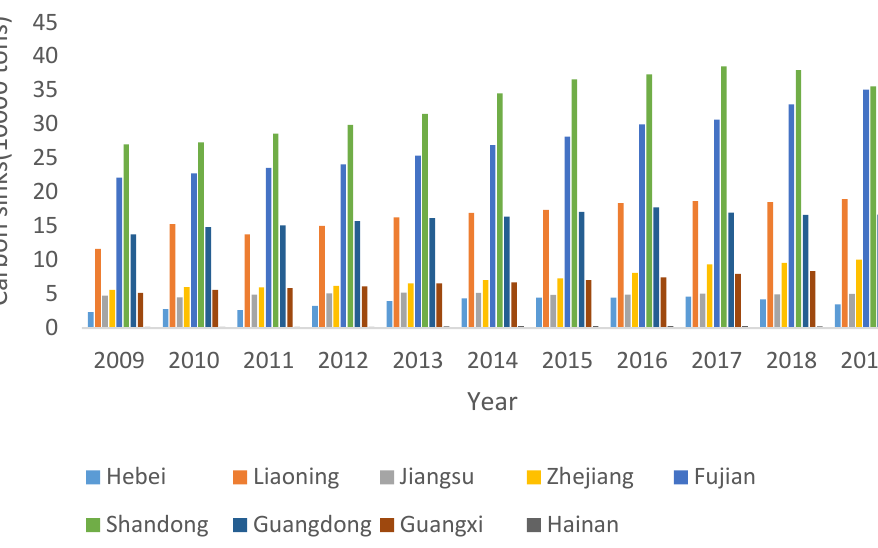
Figure 3. Carbon sinks from China’s marine fisheries from 2009 to 2019.